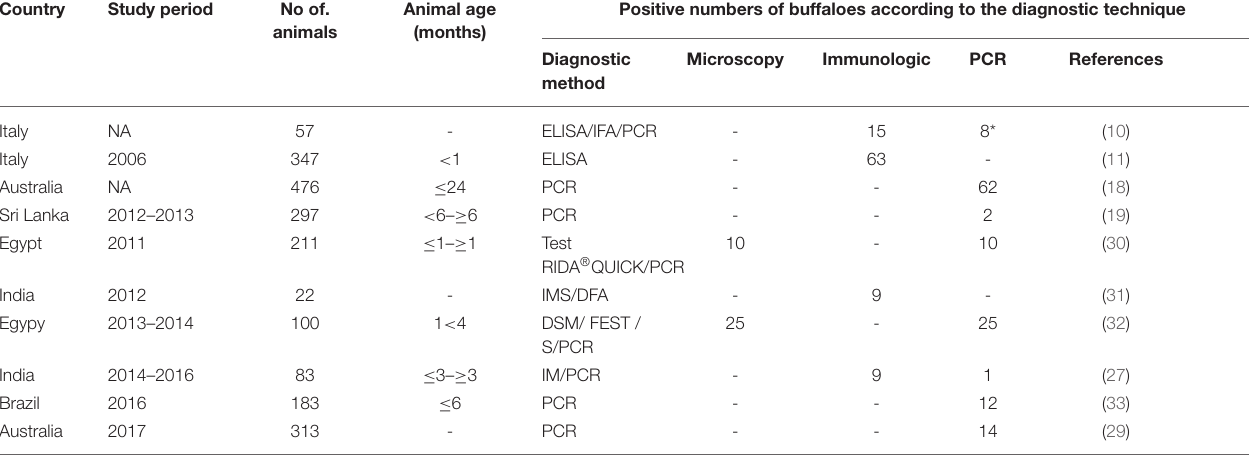
TABLE 2 | Occurrence of G. duodenalis in buffaloes worldwide using different diagnostic techniques.